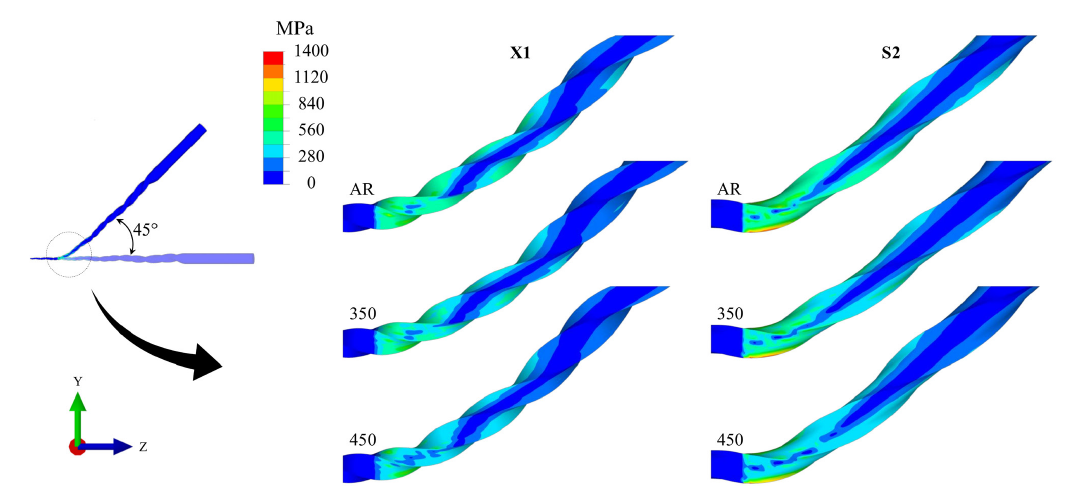
Figure 4. The von Mises stress distribution along with the body instruments under bending at 45°.